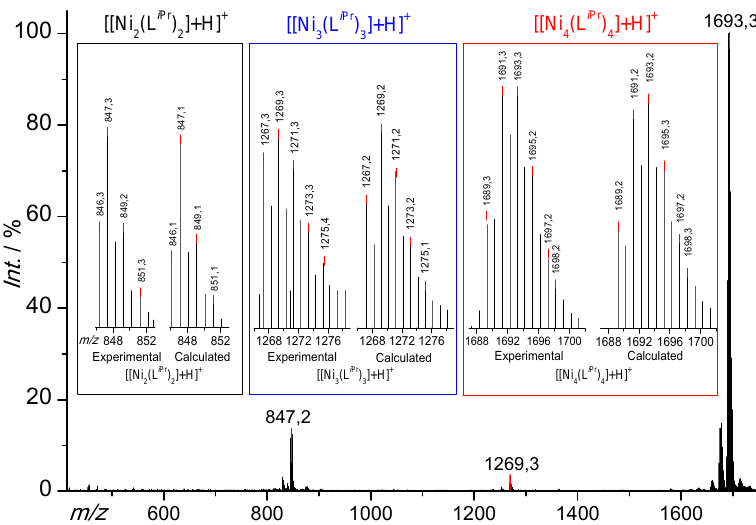
Figure 1. ESI-MS (pos.) of [Ni 4 (L i Pr ) 4 ] obtained from an acetone solution. The inserts show the fragments corresponding to the binuclear, trinuclear, and tetranuclear species (from left to right) with simulations.